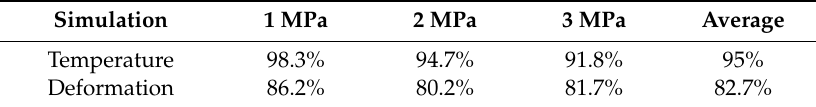
Table 4. Accuracy of the simulation.